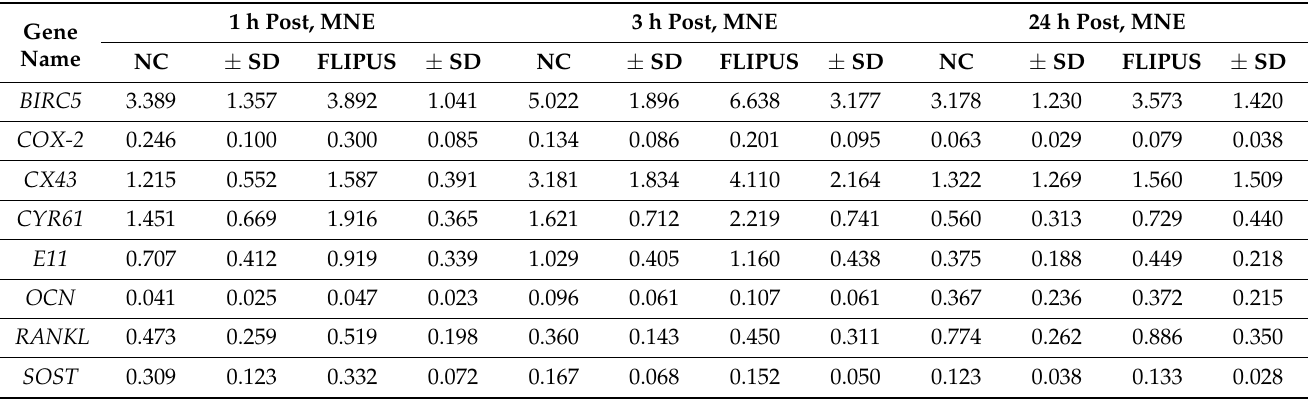
Table A2. Absolute mean normalized expression (MNE) values of gene expression kinetics after 10 min FLIPUS